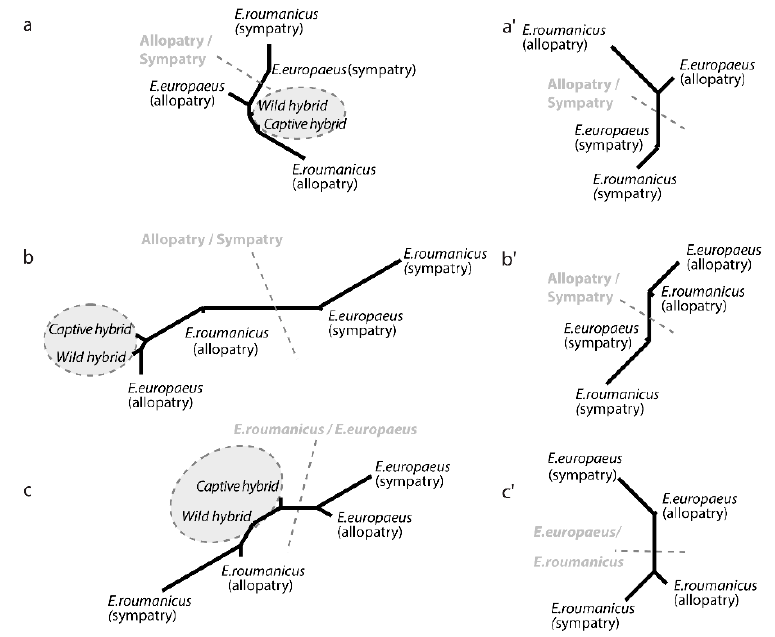
Figure 5. Overall shape differences among examined groups of E. europaeus and E. roumanicus : Right—between sympatric and allopatric populations of the two species; left—among all groups (allopatric, sympatric and hybrid populations). Neighbour-joining networks of the Mahalanobis distances for the mandible ( a , a’ ), and the ventral ( b , b’ ) and dorsal ( c , c’ ) sides of the cranium. MCI yielded values of 0.426 for the ventral and 0.441 for the dorsal side of the cranium, indicating the absence of convergence, while for the mandible, a convergence pattern with the MCI value of